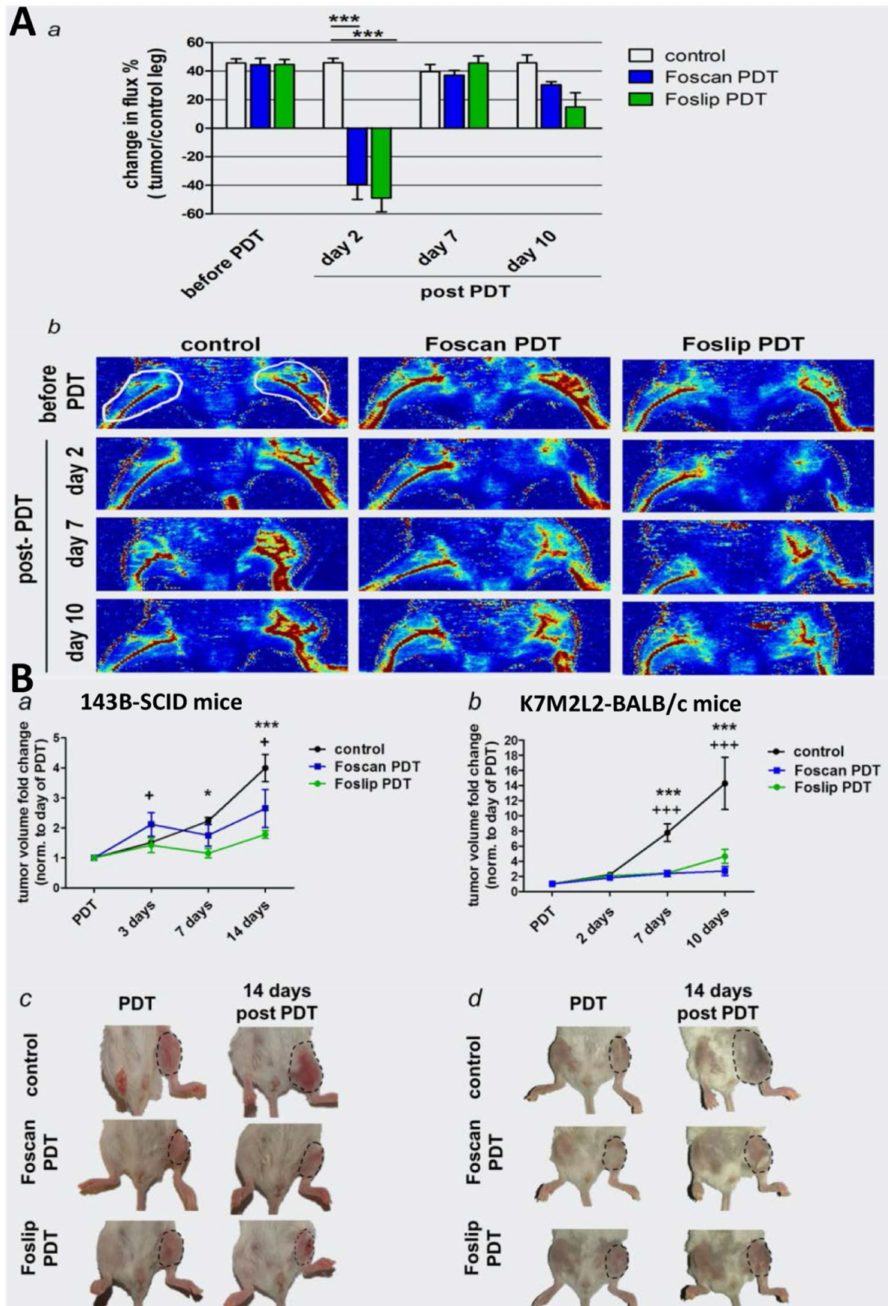
Figure 1. Inhibition of intratibial osteosarcoma growth based on PDT using Foscan or Foslip. ( A ) ( a ) Blood flow in control and tumor-bearing hind limbs was measured with a laser Doppler perfusion imager in the regions of interest (ROI) (as indicated in ( b )), and the data are presented as percent change in perfusion (flux) of tumor compared to normal tissue, *** p < 0.001. ( b ) Images of hind limb perfusion. White circles indicate ROI for laser Doppler image analysis. ( B ) ( a ) Mean fold change in size of intratibial 143B cell line-derived tumors in SCID mice and ( b ) of intratibial K7M2L2 cell line-derived tumors in syngeneic BALB/c mice. + p < 0.05, +++ p < 0.001, Foscan PDT vs. control; * p < 0.05, *** p < 0.001, Foslip PDT vs. control. ( c , d ) Photographs taken at the end of treatment study. Dotted lines indicate tumor areas. Reproduced from ref. [90] with permission from Wiley Online Library. Copyright (2017) International Journal of